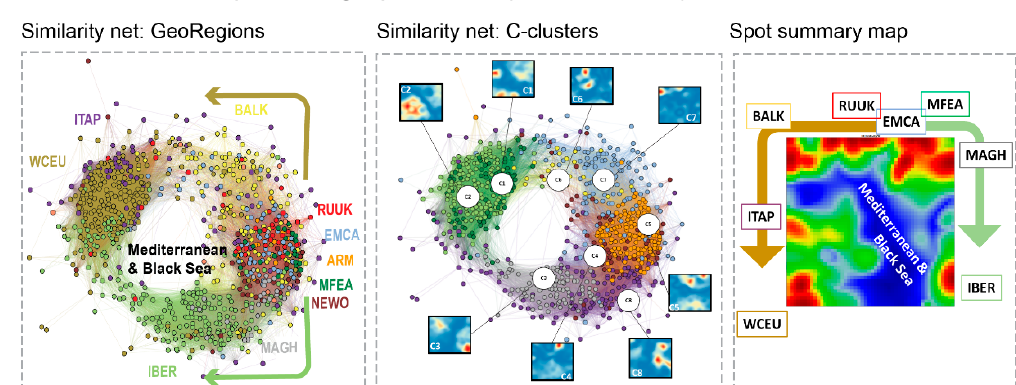
Figure 4. Distribution of grapevines around the Mediterranean and Black Sea: ( A ) Country-wise ANOVA portraits of cultivars are linked by a ‘metro-net’, which visualizes the relatedness between similar portraits in neighboring countries. ( B ) The network of mutual correlations between the SNP-portraits arranges them in a ring-shaped fashion, resembling the ordering of geographic regions around the Mediterranean and Black Sea. Moreover, the activated spots in the SOM order roughly in this way. Recoloring of the cultivars using the eight ‘C’-clusters taken from [11] sorts them in a consecutive way.